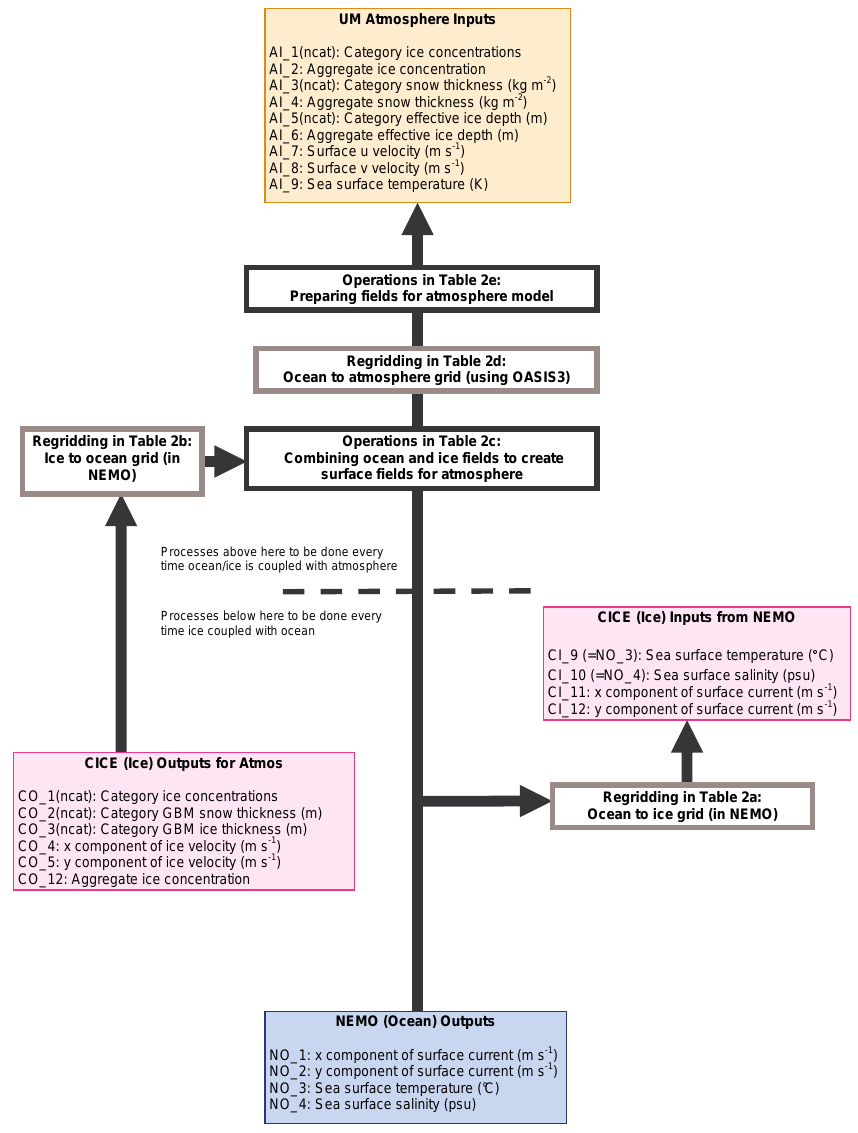
Figure 5: Flow diagram showing the coupling of the 3 submodels in HadGEM3 in the direction ocean to sea ice to atmosphere. Tables 2a–e detail the operations and regridding shown in the figure. Temporary fields are listed in Table 2f and constants used in the coupling are shown in Table 2g. Details of annotation are given in the caption for Fig. 4. Table 2b. Details of regridding the ice fields onto the ocean U and V points in Fig. 5. These manipulations are in the NEMO subroutine CICE SBC OUT